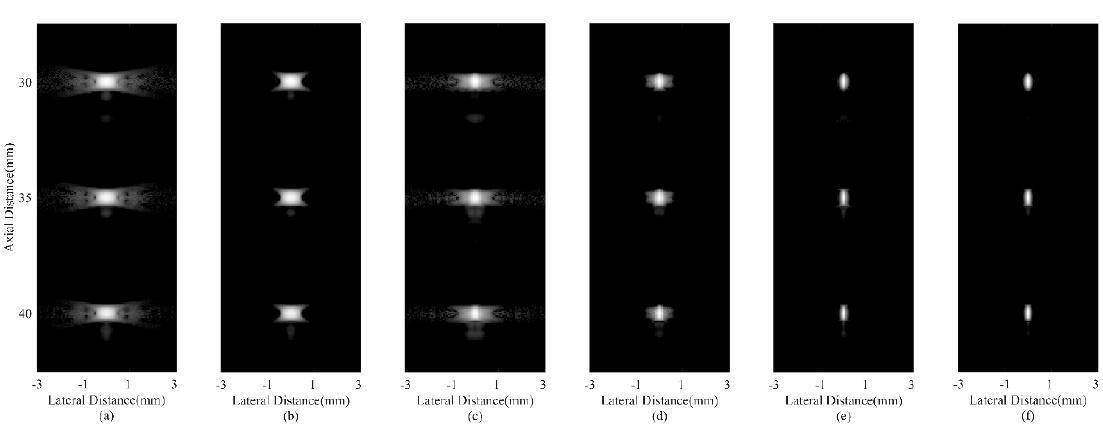
GCF, ( e ) JTR-ESBMV, ( f ) JTR-ESBMV GCF. All images are shown with a dynamic range of 60 dB.